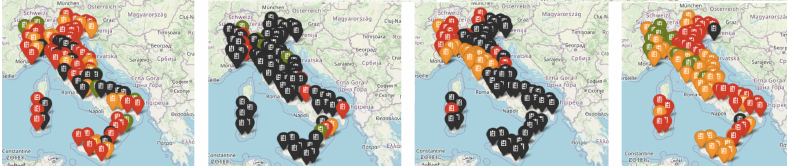
Figure 3. Comparison of R 0 index values on 10 September 2020, 10 October, 10 November, 10 December, for provinces where the number of deaths is available. Green pins are for 0 ≤ R 0 < 0.5, orange pins for 0.5 ≤ R 0 < 1, red pins for 1 ≤ R 0 < 2 and black pins for R 0 ≥ 2.